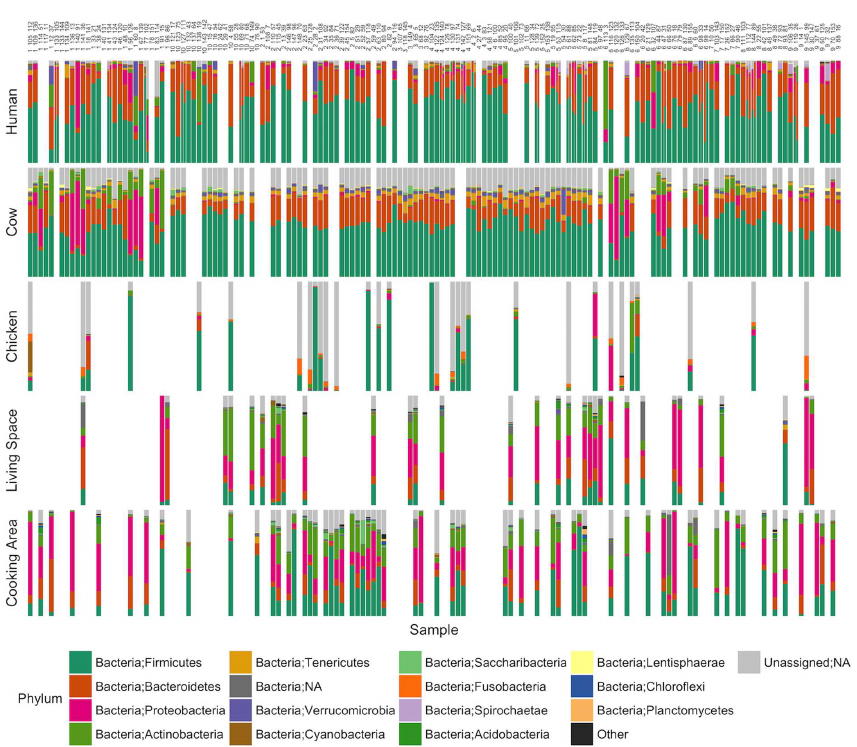
Fig 1. Bar charts representing the relative abundance of phyla in the gut microbiomes of children, cattle, and chickens, and in environmental microbiomes from living spacesand cooking areasin households in western Kenya. Each column represents a single household. In households where two childrenwere sampledthe humanbar plot is dividedevenly down the center. Samples with missing data are blank while unassigned taxa are